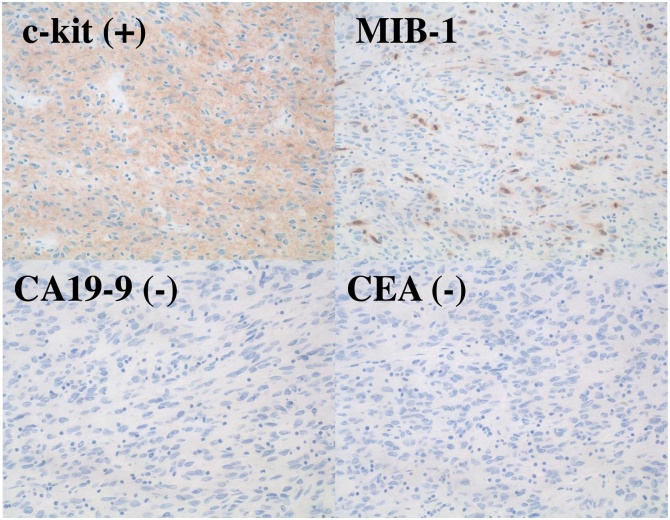
Immunohistochemically, the tumor was strongly positive for c-kit and negative for CA19-9 and CEA. The MIB-1 labeling index was <10 %.